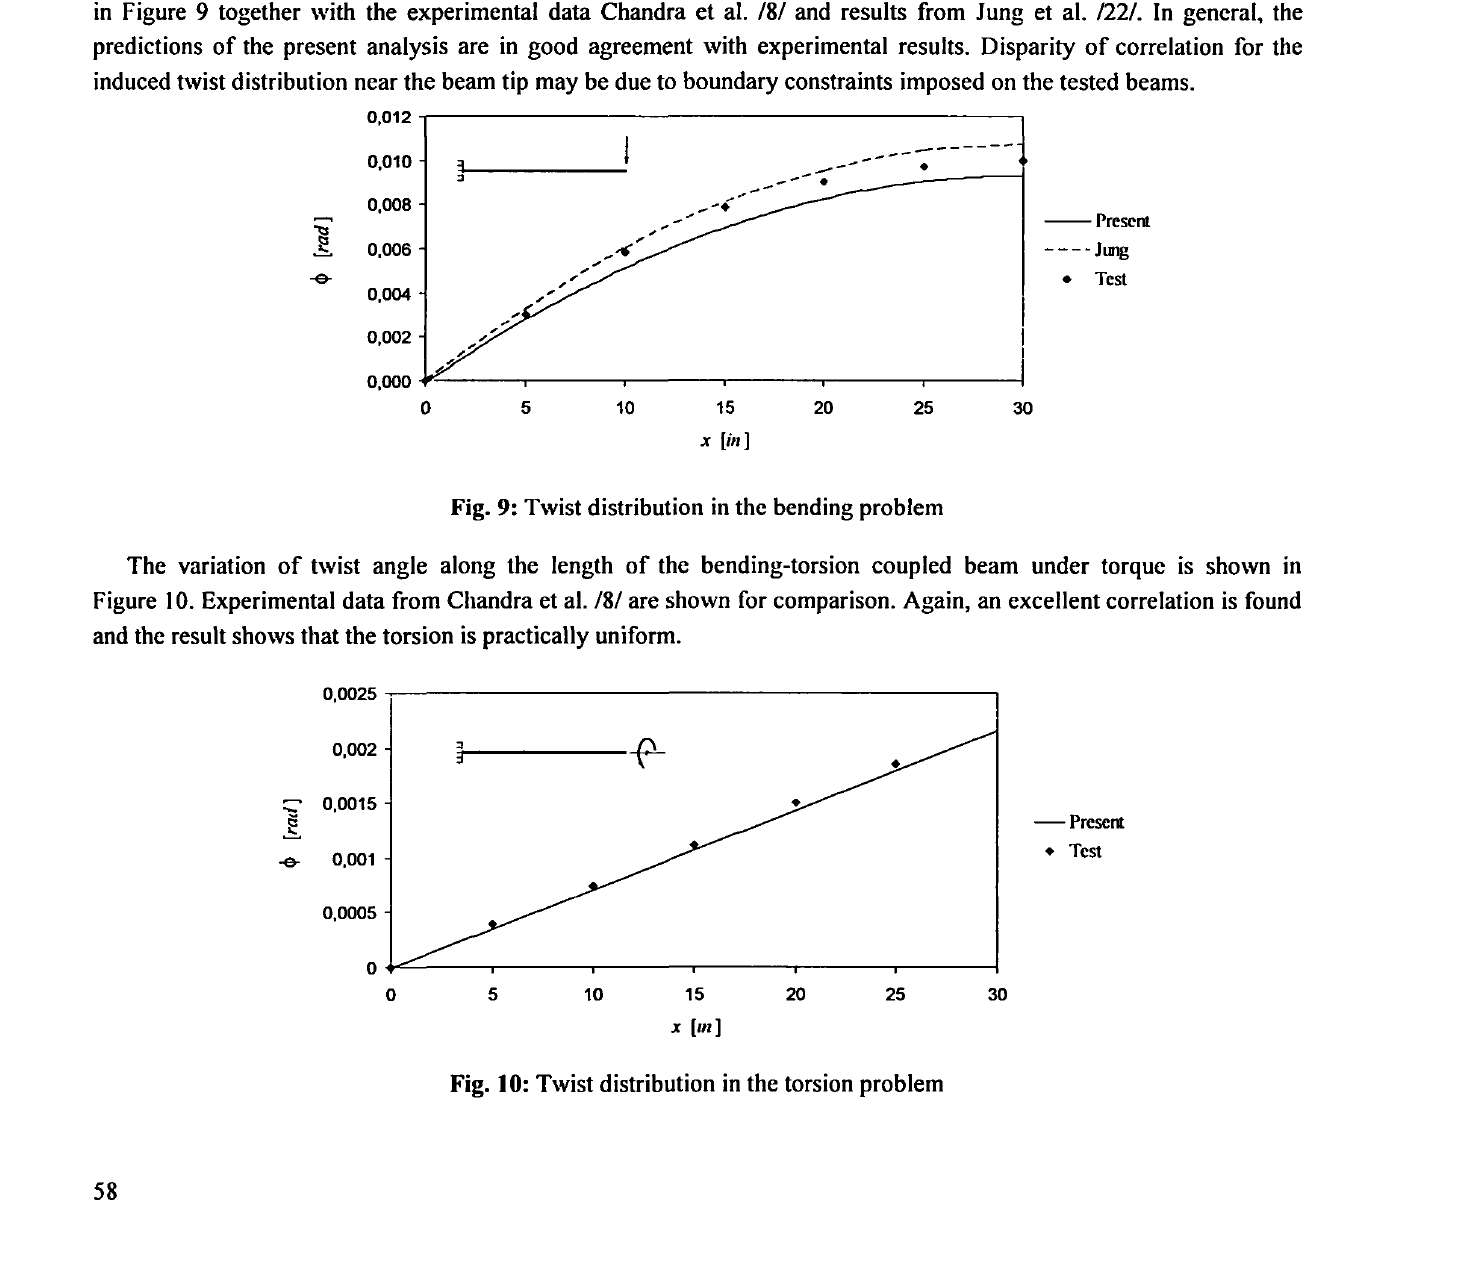
Fig. 8: Bending slope distribution in the bending problem